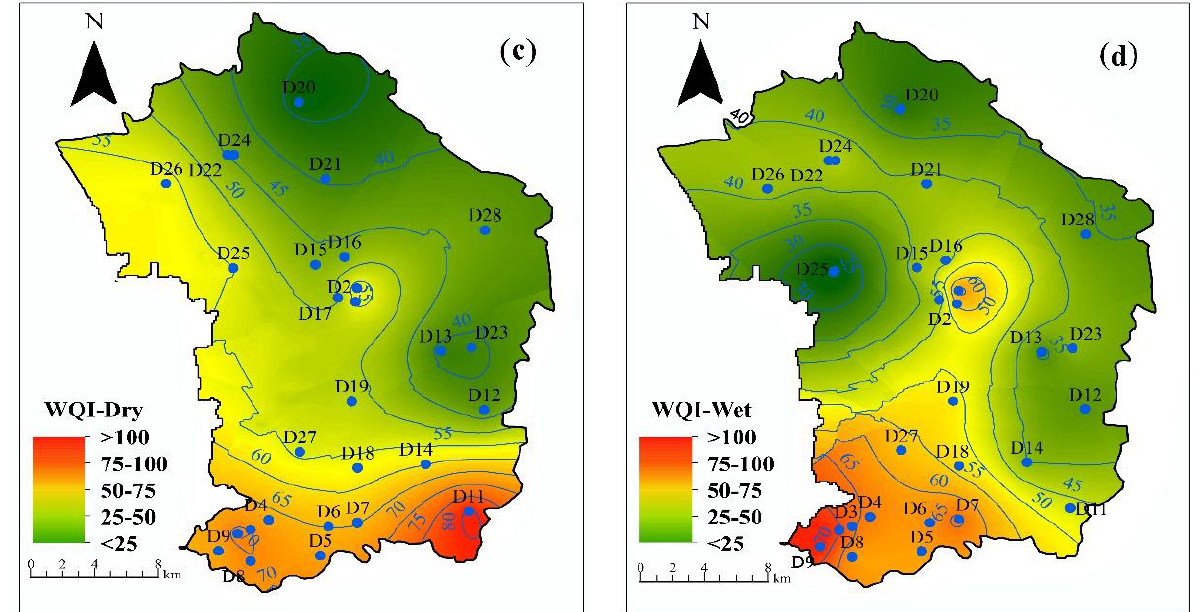
Figure 6. Distribution map of IWQI and WQI in the study area. ( a ) IWQI value in dry season. ( b ) IWQI value in wet season. ( c ) WQI value in dry season. ( d ) WQI value in wet season.